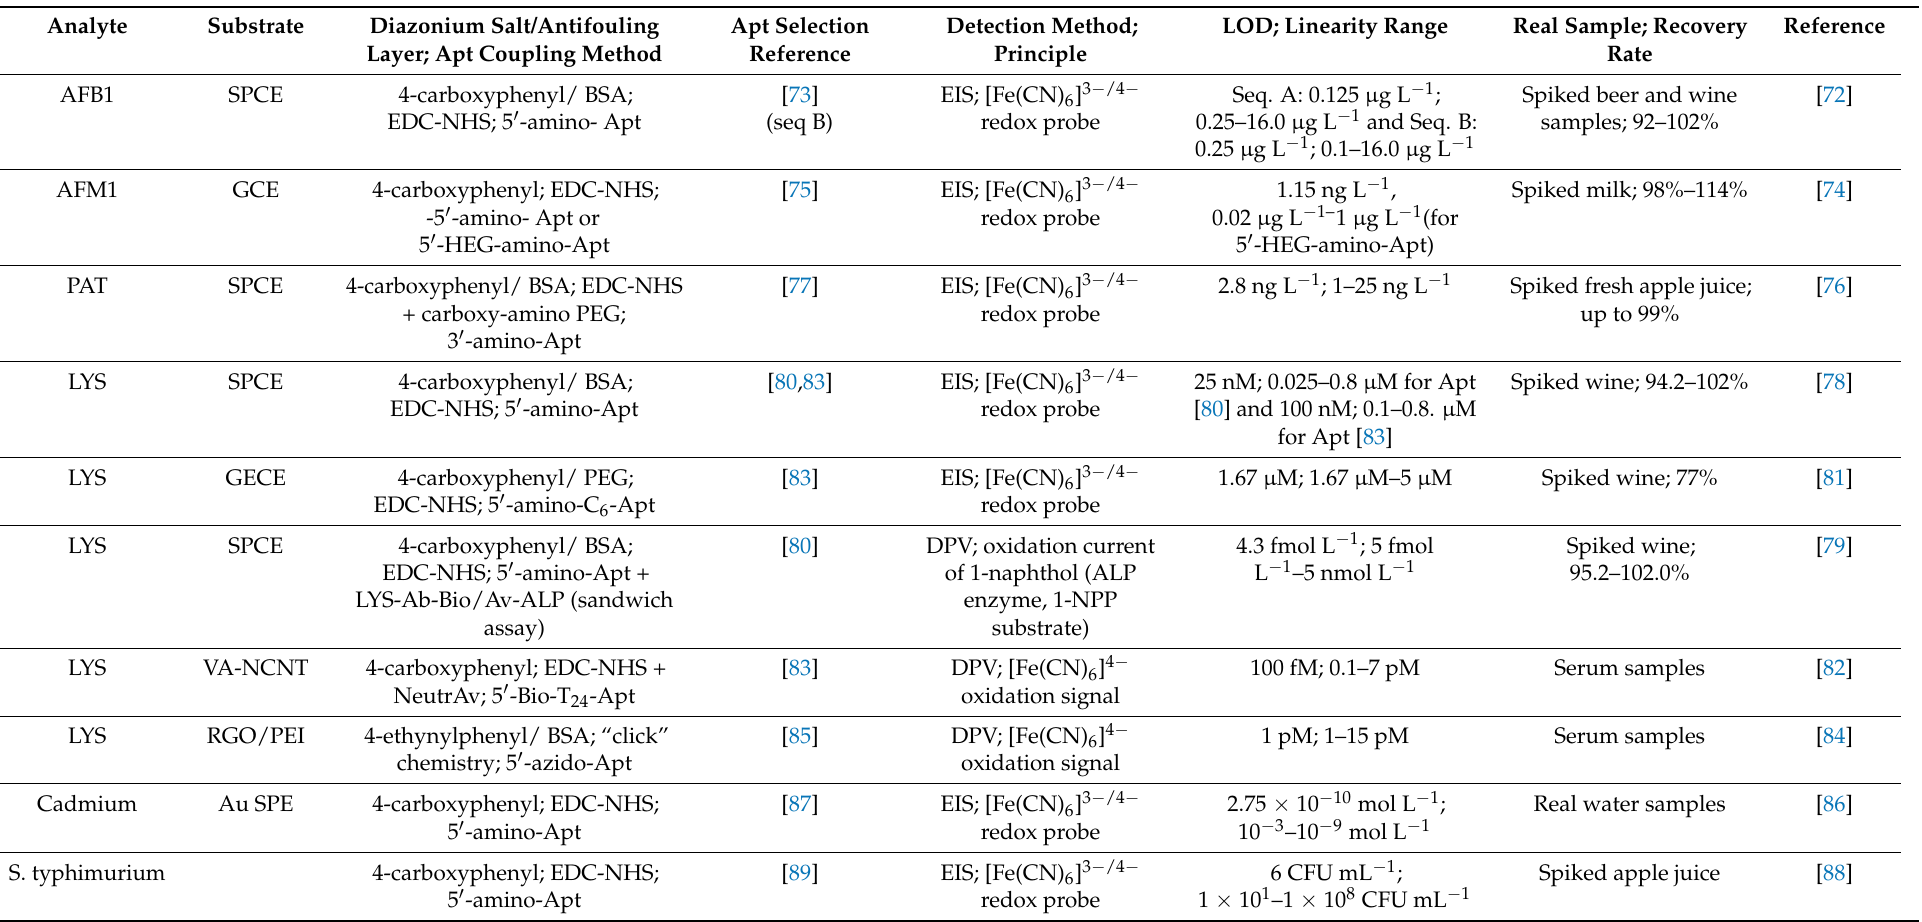
SPCE: screen-printed carbon electrode; Apt: aptamer; GC: glassy carbon electrode; GA: glutaraldehyde; ALP: alkaline phosphatase; 1-NPP: 1-naphthyl phosphate; PGE: pencil graphite electrodes; HEG: hexaethyleneglycol; GECE: graphite–epoxy composite electrodes; Ab: antibody; Bio: biotin; Av: avidin; NeutrAv: neutravidin; T: timine; RGO: reduced graphene oxide; PEI: polyethyleneimine; CFU: colony-forming